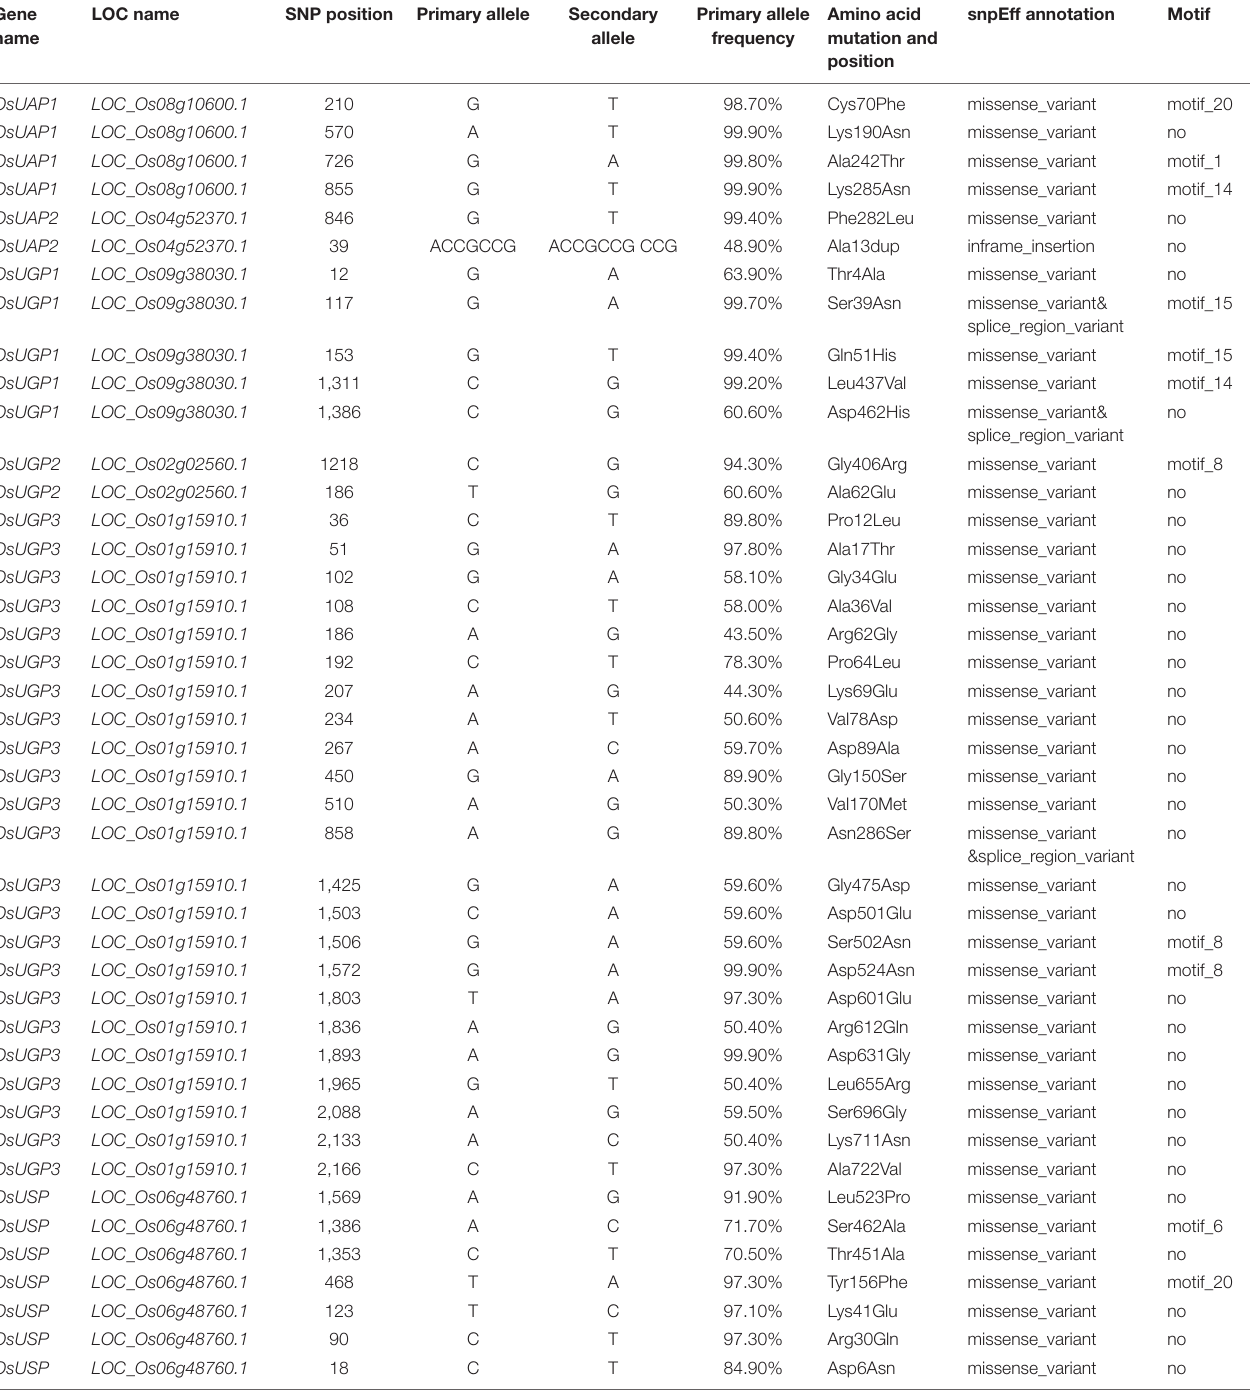
TABLE 1 | Natural variant of UDPGP genes in